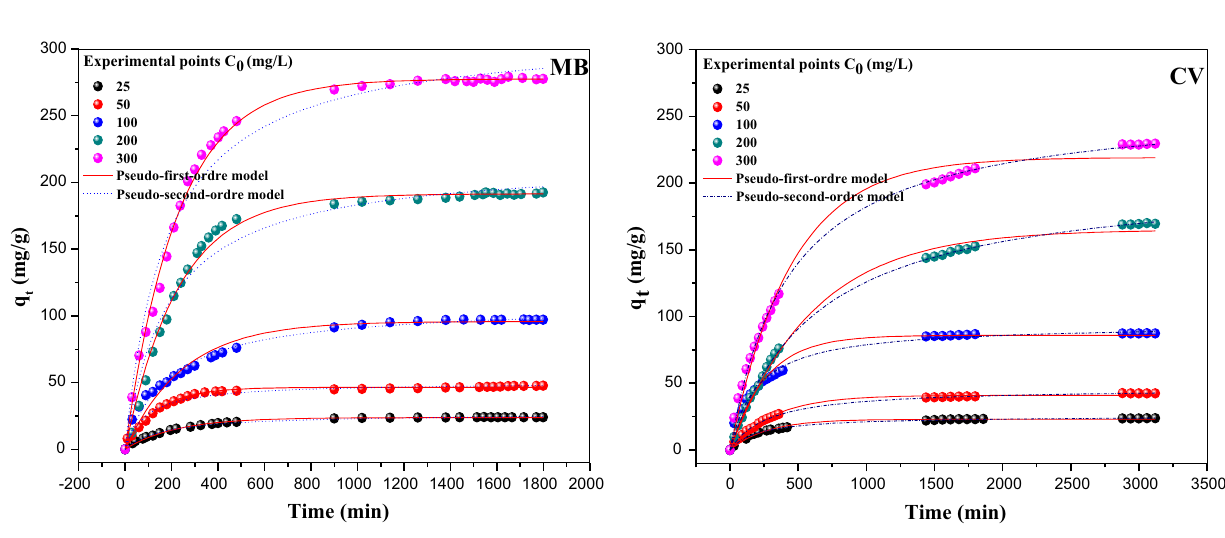
Fig. 6 Experimental data and modeling of adsorption kinetics of MB and CV onto ABent/A beads ( C